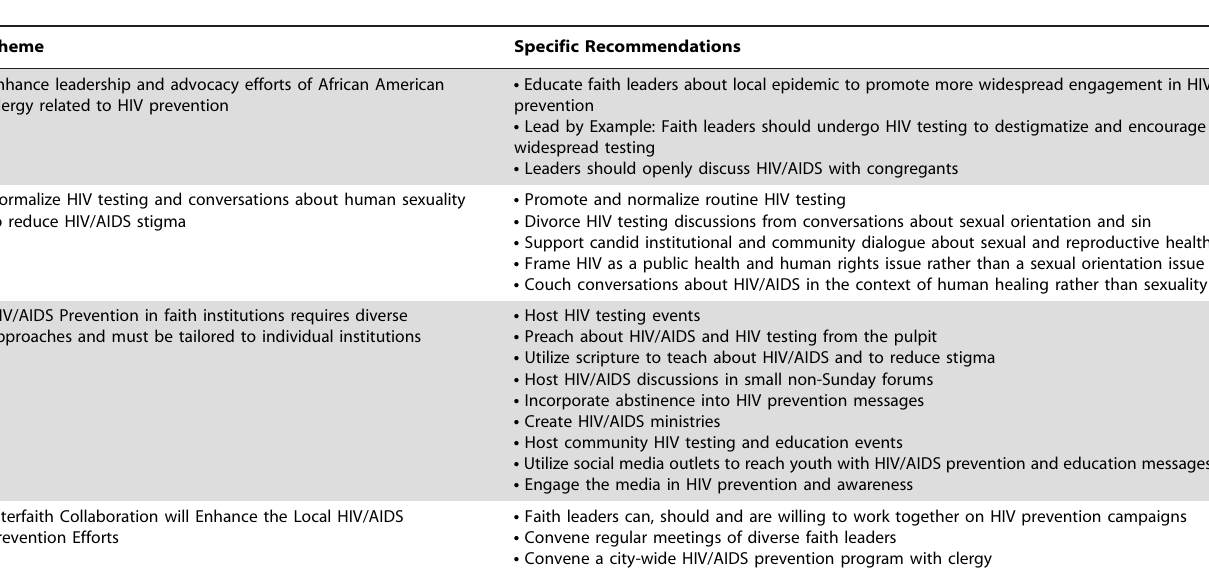
Table 3. Faith Leaders’ Recommendations for Enhancing HIV/AIDS Prevention in Faith-Based